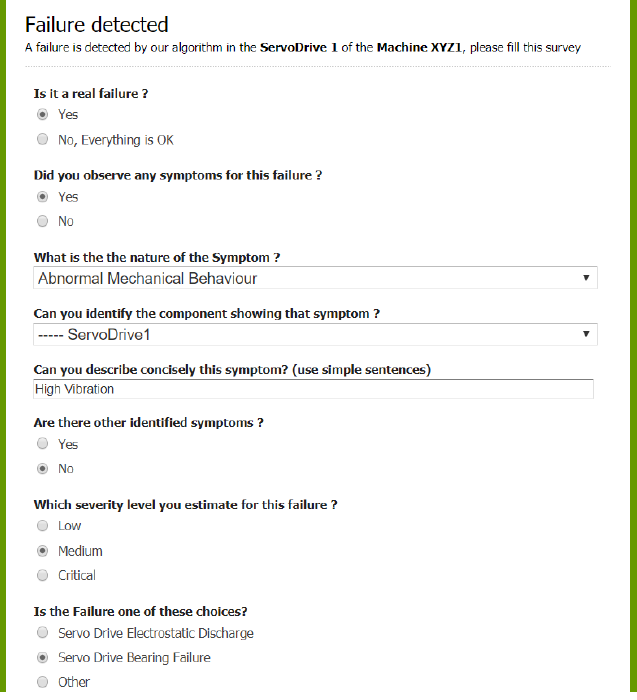
Figure 6. Screenshot of the failure